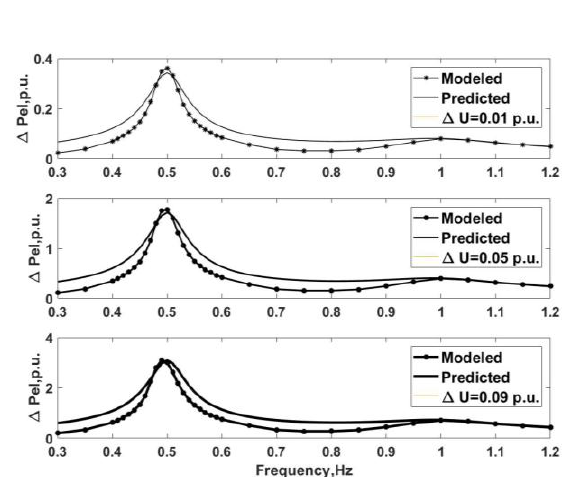
Fig. 3. Electric power perturbations of G3 generator predicted by formula (6) and obtained in simulation as a function of an input frequency